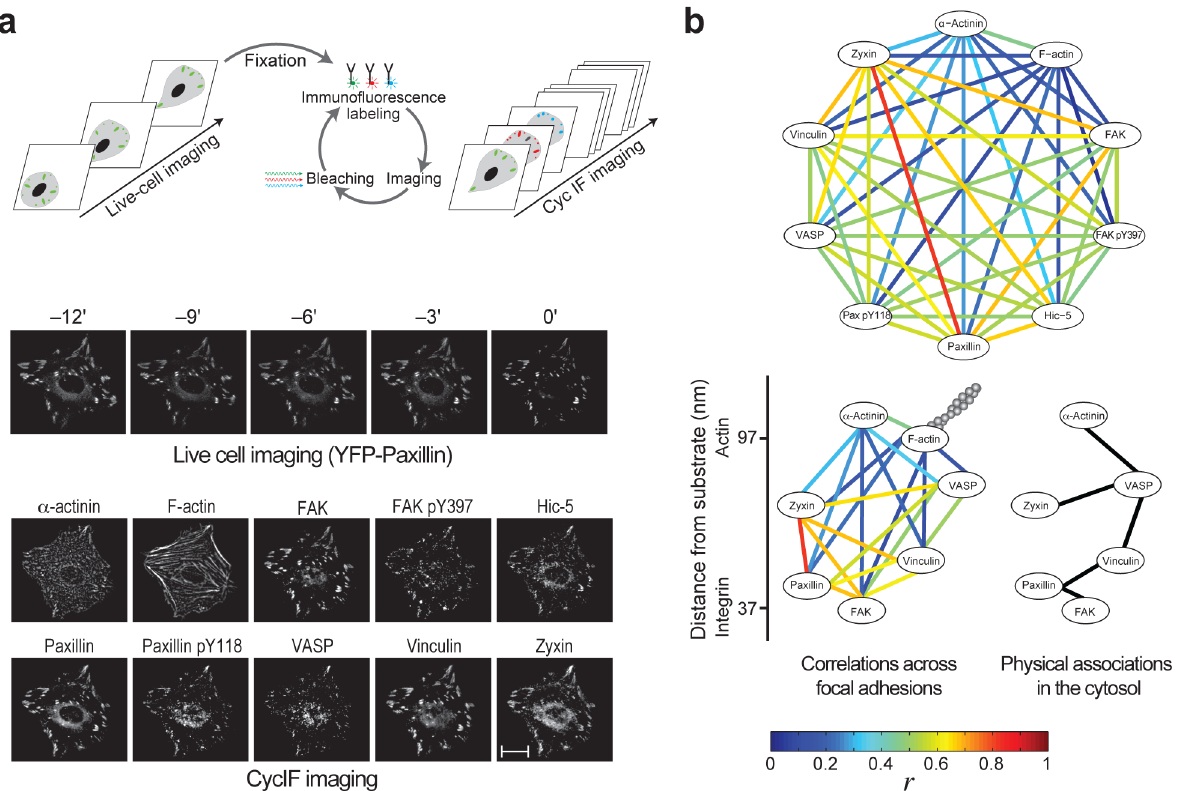
Fig 1. High-throughput CycIF imaging of cell-matrix adhesion sites. (a) Imaging procedure and an example of the images obtained for a cell. Scale bar, 10 μ m. (b) Top, the mean Pearson correlation coefficients ( r , n = 6 datasets; see S2 Table) between the densities of the components. Bottom, superposition of these correlations with the reported vertical positions of the components across focal adhesions [26] (left) and a comparison with their reported physical associations in the cytosol [33] (right).